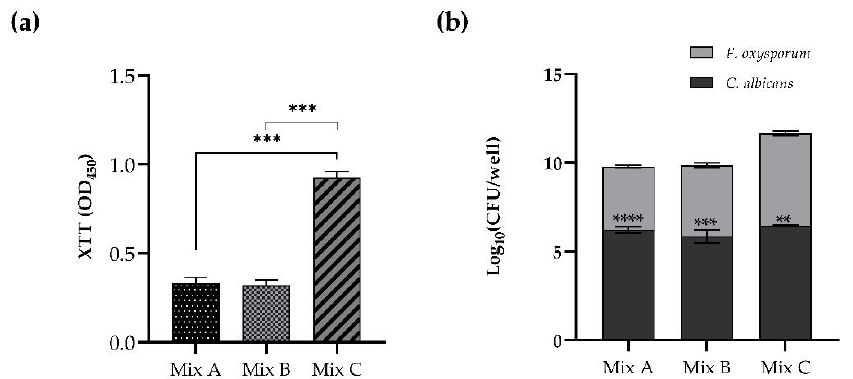
Figure 2. Panel ( a ). Metabolic activity of mixed biofilm. F. oxysporum inocula were dispensed, as first colonizer, allowing adherence (4 h, Mix A), formation (24 h, Mix B), and maturation (48 h, Mix C) before C. albicans addition h. Panel ( b ). Competitive behavior during formation of mixed biofilm. Log of colony-forming units (CFU) per well isolated from dual-species biofilms formed in the three different conditions of Mix A, Mix B, and MixC. Significant differences were determined by Tukey’s test, ** p < 0.01; *** p < 0.001, **** p <